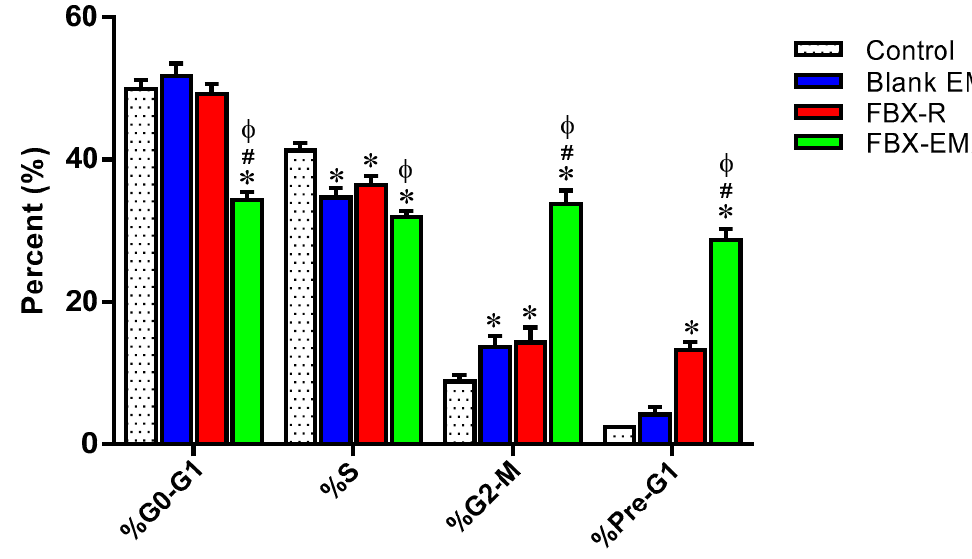
Figure 5. Impact of Blank EMLs, FBX-R, or optimized FBX-EMLs treatments on HCT 116 cell cycle phases. Data are the mean of 4 independent experiments ± SD. * Significantly different vs. Control ( p < 0.05); # Significantly different vs. Blank EMLs ( p < 0.05); Φ Significantly different vs. FBX-R ( p <